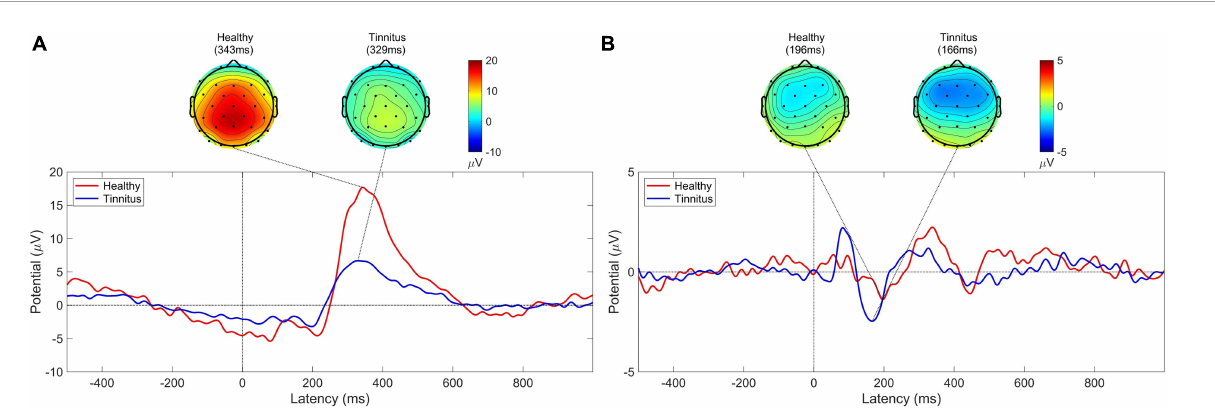
FIGURE2 P300 and MMN responses. (A) Grand-averaged P300 topographies and ERP time courses at electrode Pz of both healthy controls (red line) and patients with tinnitus (blue line) for the target stimuli during the active oddball task. (B) Grand-averaged MMN topographies and ERP time courses at electrode Fz of both healthy controls (red line) and patients with tinnitus (blue line) for the target minus standard stimuli during the passive oddball